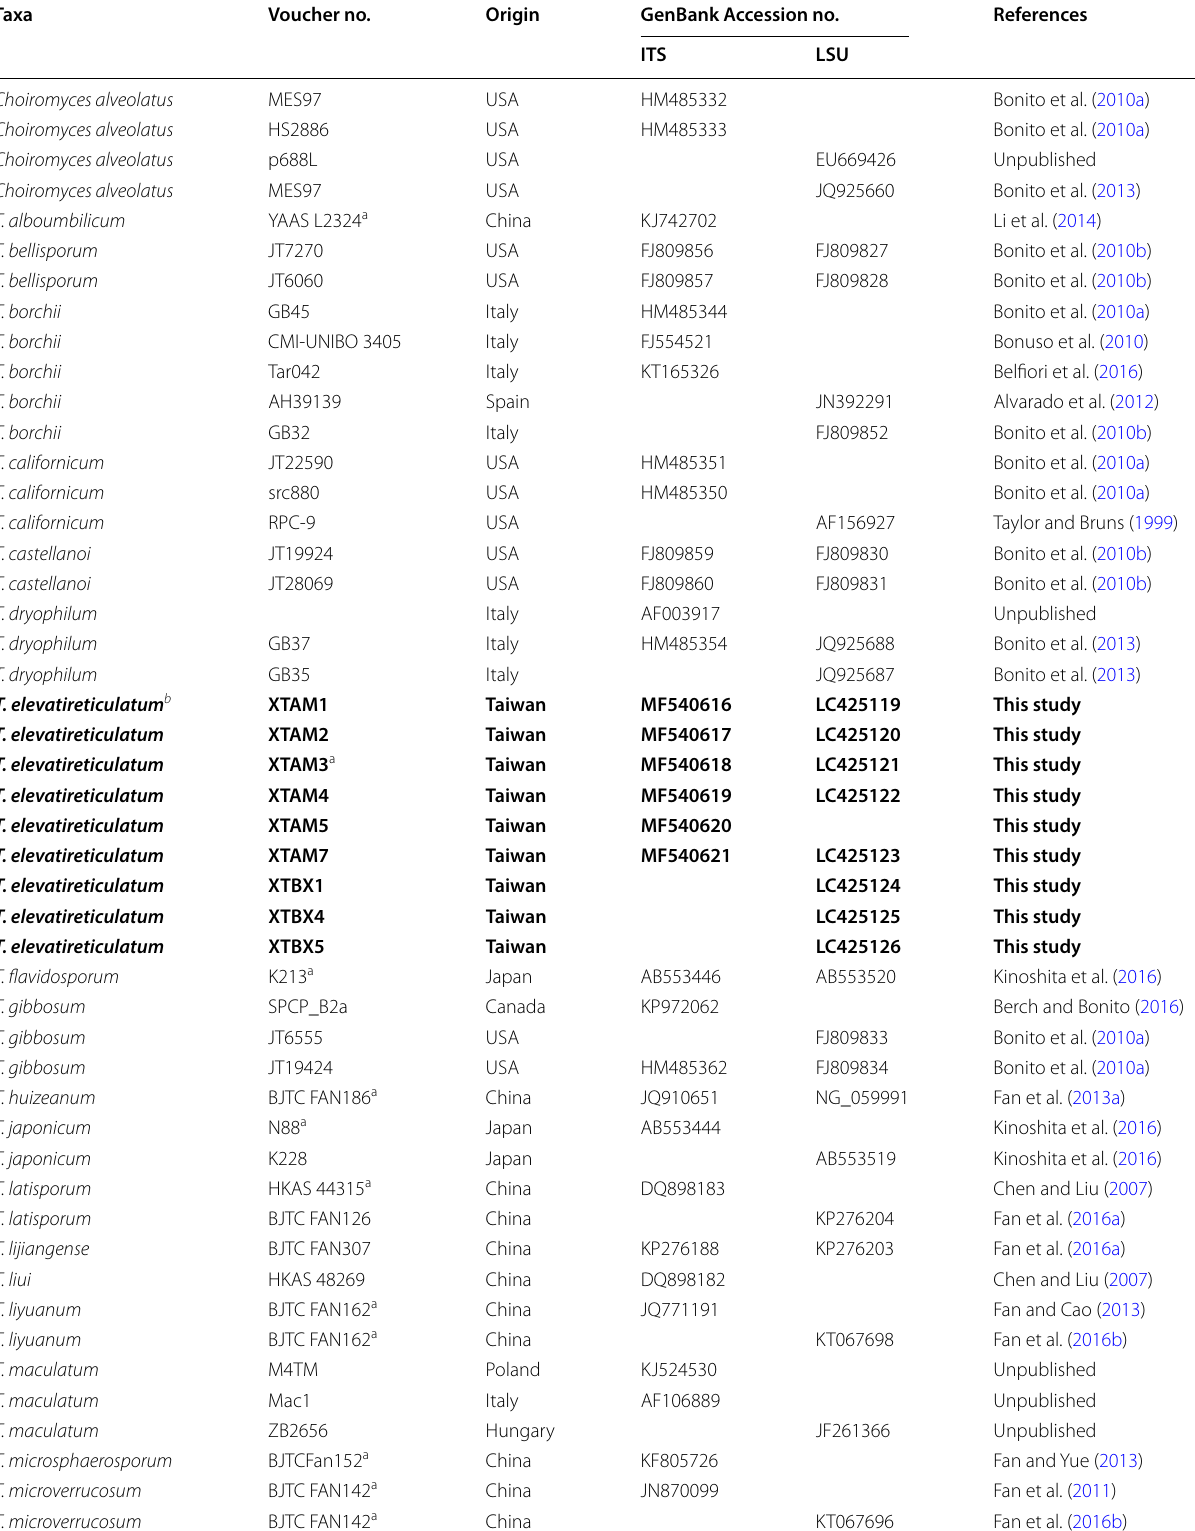
Table 1 Details of the whitish Tuber ITS sequences used in phylogenetic